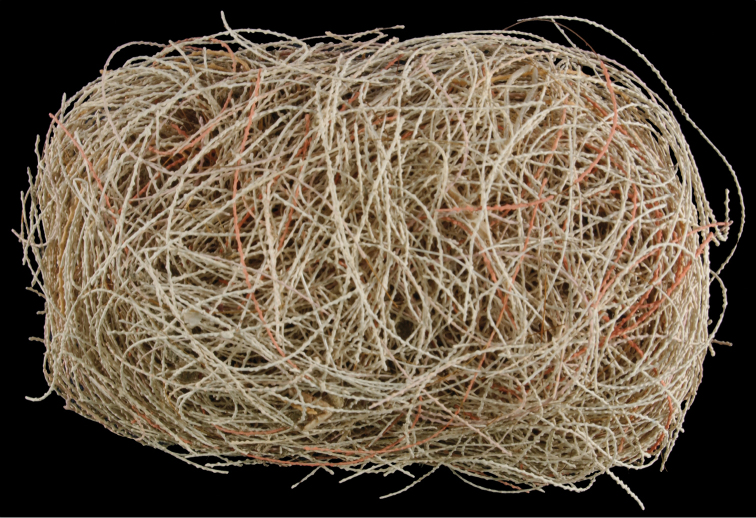
Leptogorgiafilicrispa, USNM 1106683-Paratype. Full view of an amazingly large collection of branch strands, showing the multi-colored strands; entire mass measuring 20 cm × 12–13 cm.